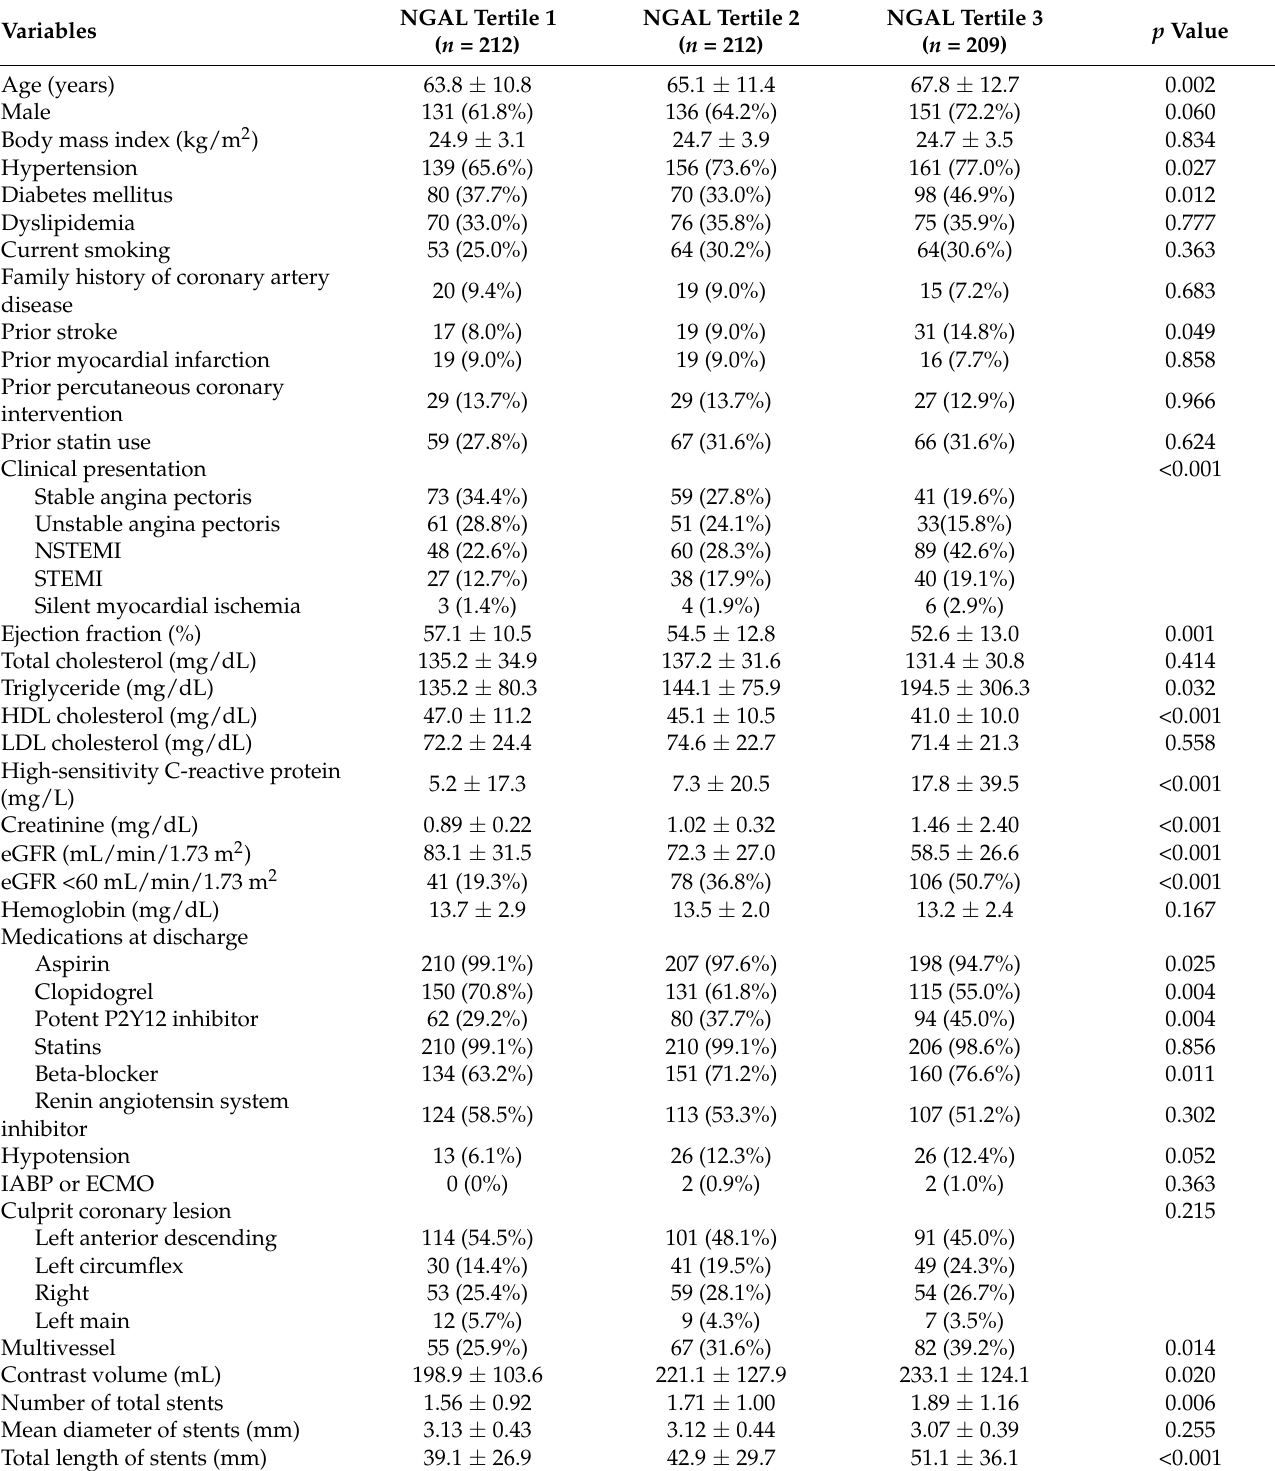
Table 1. Baseline clinical and angiographic